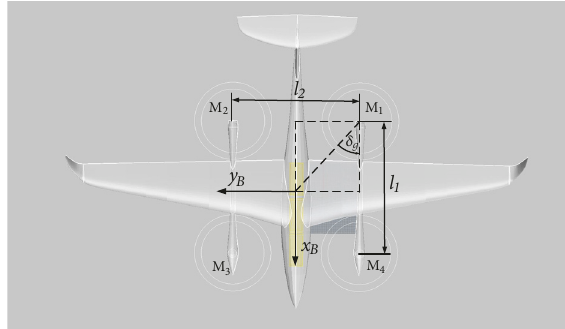
Figure 8: Configuration of the propulsion